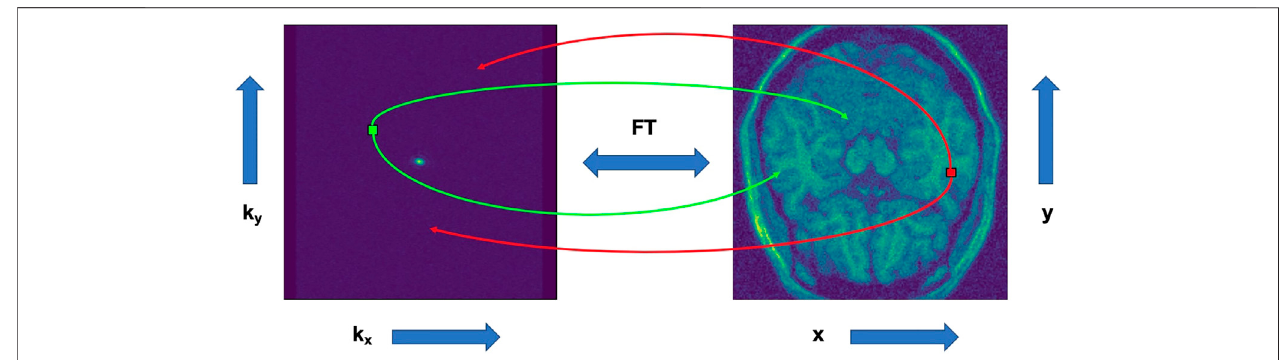
FIGURE 1 | Representation of how points translate between k-space and complex image